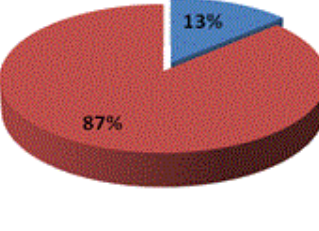
Figure 5: Number of employees per SME